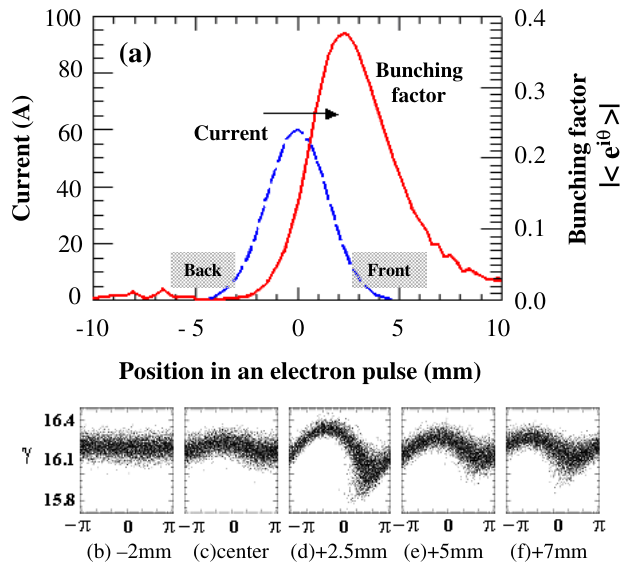
FIG. 3. (Color) Bunching factor (a) and phase space distribution at different slices (b),(c),(d),(e),(f) in the 10-ps FWHM electron pulse after the electron beam propagates 1.4 m inside undulator. The arrow shows the direction of propagation of the electron